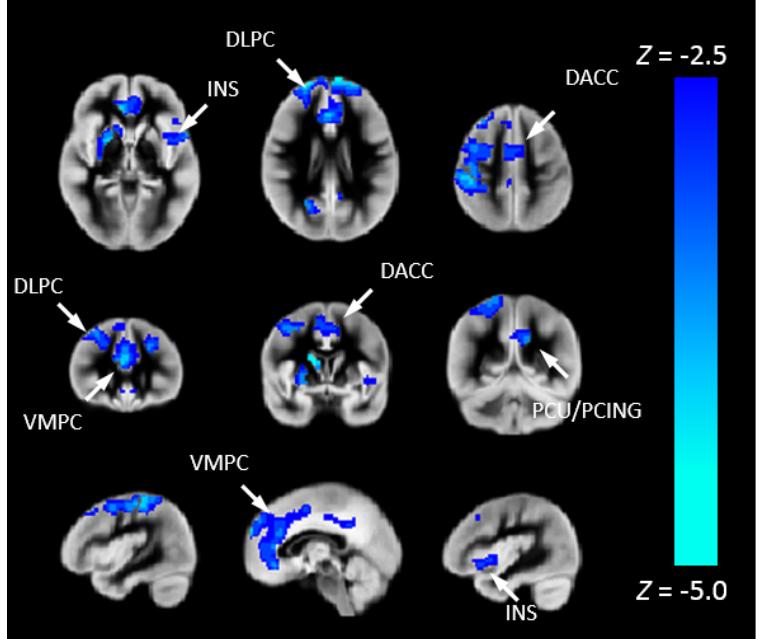
Figure 5. Reduced Pnvf mediates adverse neurocognitive outcome in children and younger adults with CHD. Regions with a negative indirect effect with CHD status the independent variable, NIH Toolbox Total Cognition Composite score the dependent variable, and Pnvf the mediator (control- ling for age and gender) are mainly concentrated in DMN, SN, and CEN regions. All significant regions demonstrating statistically significant mediations (indirect effects) are depicted with blue voxels at FDR-corrected q < 0.05. Abbreviations: Ventrolateral medial prefrontal cortex (VMPC), Insula (INS), Dorsolateral prefrontal cortex (DLPC), Posterior Cingulate (PCING), Precuneus (PCU), Dorsal Anterior Cingulate Cortex (DACC), Posterior Parietal (PP). 3.4. nNO Analysis To more closely associate Pnvf with neurobiology, we correlated Pnvf with nNO measurements in the subset of participants for which nNO measurements were available. Positive correlations of Pnvf with nNO measurements were found (Figure 6) in frontal DMN and CEN regions, with particularly strong correlations in subcortical regions (pu- tamen). Next, we investigated whether reduced Pnvf in CHD patients is mediated by nNO. We also found a negative indirect effect (Figure 7) in these regions.